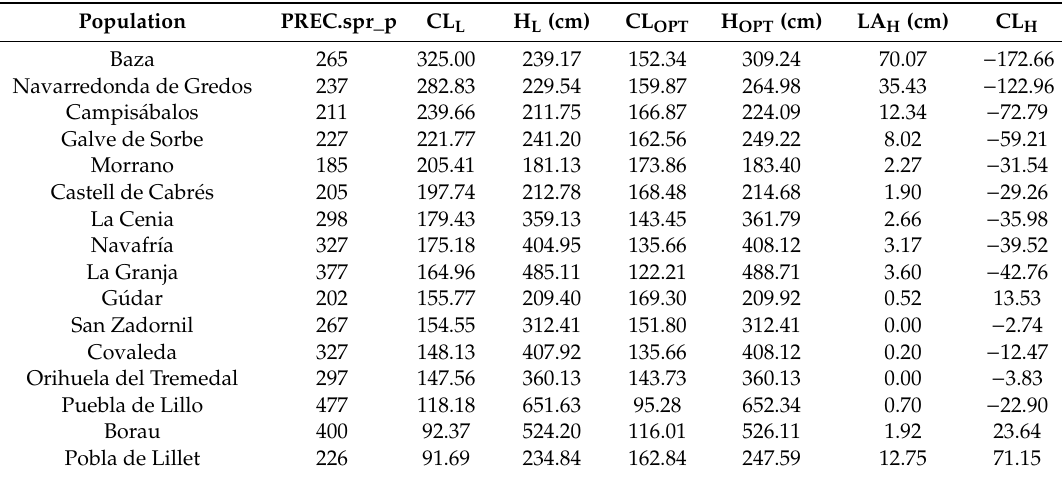
Table 4. Predictions of local tree height growth, H L (cm), and optimum tree height growth, H OPT (cm), for each population, based upon the best supported model.